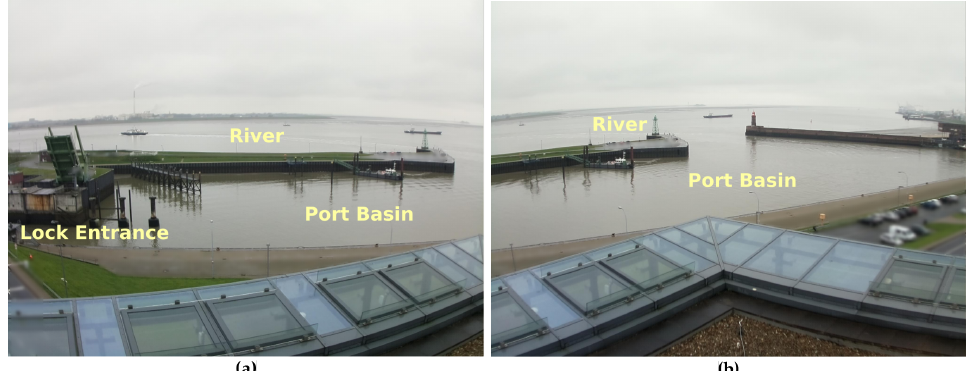
Figure 1. View of each camera used for ShipSG data collection, showing the river, port basin and lock entrance. ( a ) View of first camera. ( b ) View of second